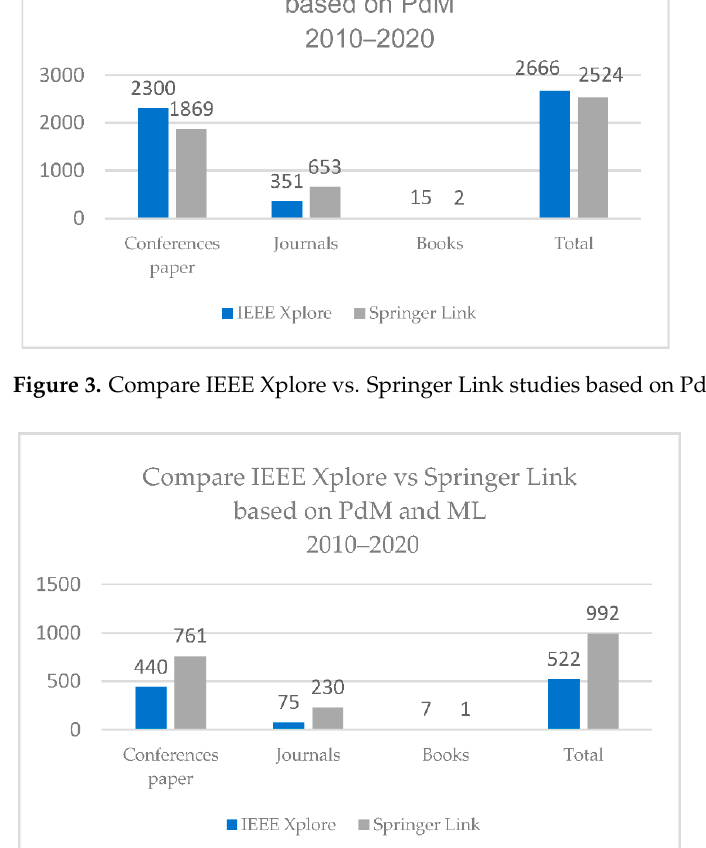
Figure 5. Compare IEEE Xplore vs. Springer Link studies based on PdM and SMEs. Although the focus of this research was on project-oriented studies, considering the research articles, a total of 36 studies were extracted to answer the questions raised at the beginning of the review. These studies are the most relevant regarding maintenance and prediction as well as for instructions on how to apply this process in small industries.